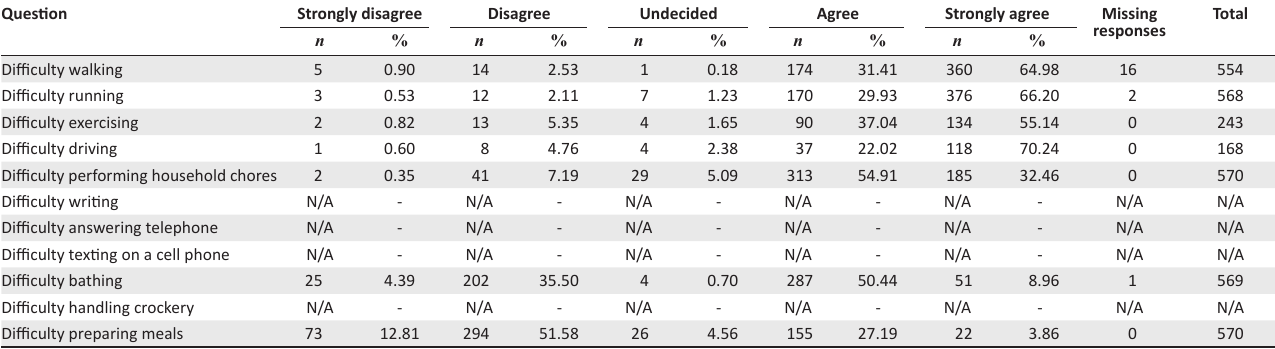
TABLE 3: The impact of lower limb fractures on daily functioning ( n = 570).